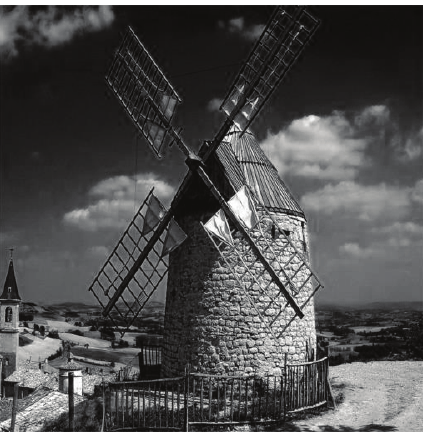
Figure 1: The original gray image of windmill.